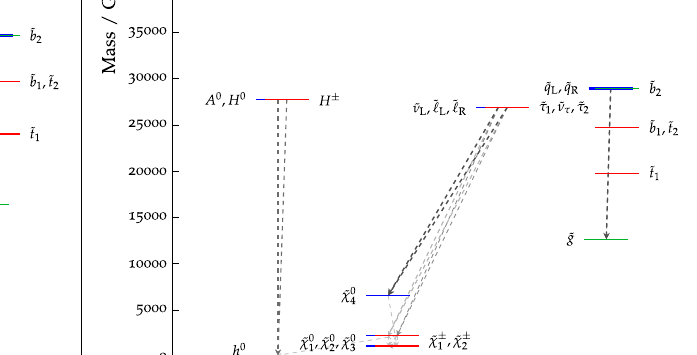
case, we also indicate all the decay modes with branching ratios (BRs) above 20%, with darker shading for larger BRs, and the colours of the horizontal bars reflect particles electric charges